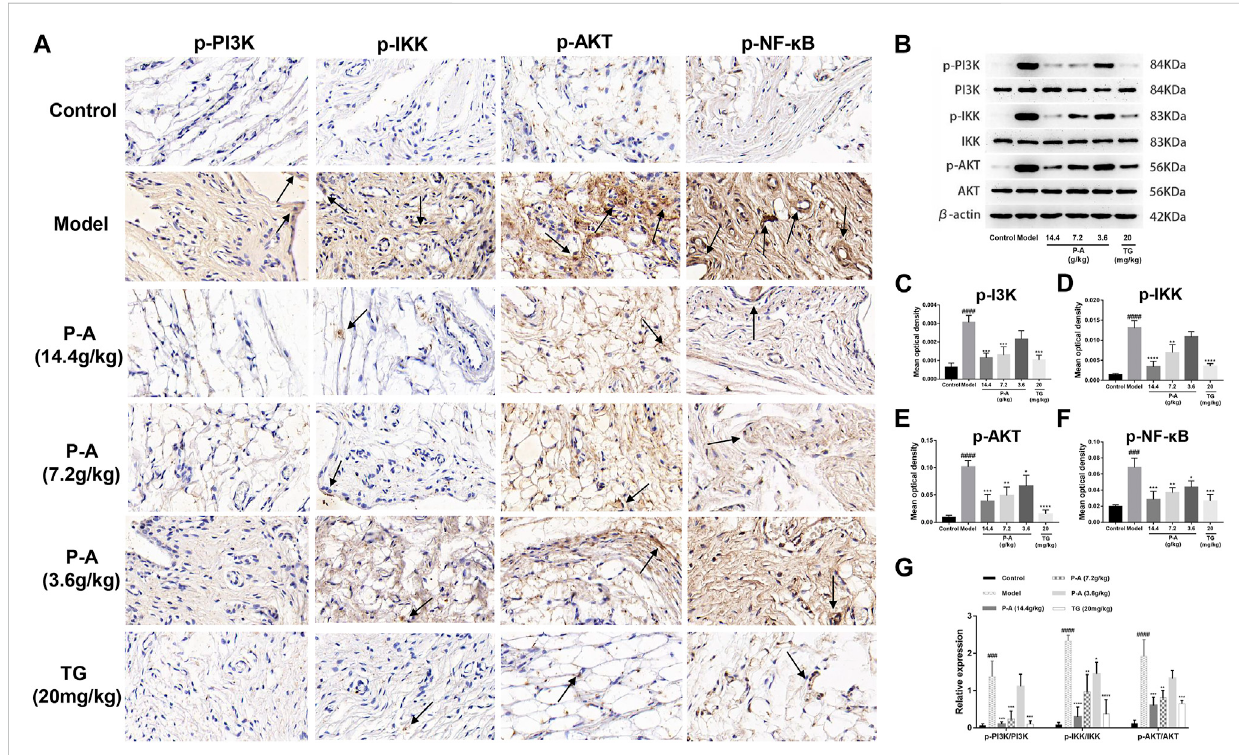
FIGURE 9 (A) Distribution of p-PI3K, p-IKK, p-NF- κ B, and p-AKT positive cells in the synovial tissue of the ankle joint in each group (immunohistochemical method, ×100). (B) Effect of the P-A drug pair on PI3K, IKK, and AKT protein expression and their phosphorylation levels. (C – F) Quantitative analysis of p-PI3K,p-IKK,p-AKTandp-NF- κ B. (G) Quantitativeanalysisof p PI3K/PI3K,p-IKK/IKKandp-AKT/AKT.Thedatarepresentthemean±SD.# p < 0.5,## p < 0.01, ### p < 0.001, #### p < 0.0001 vs. control group; * p < 0.5, ** p < 0.01, *** p < 0.001, **** p < 0.0001 vs. model